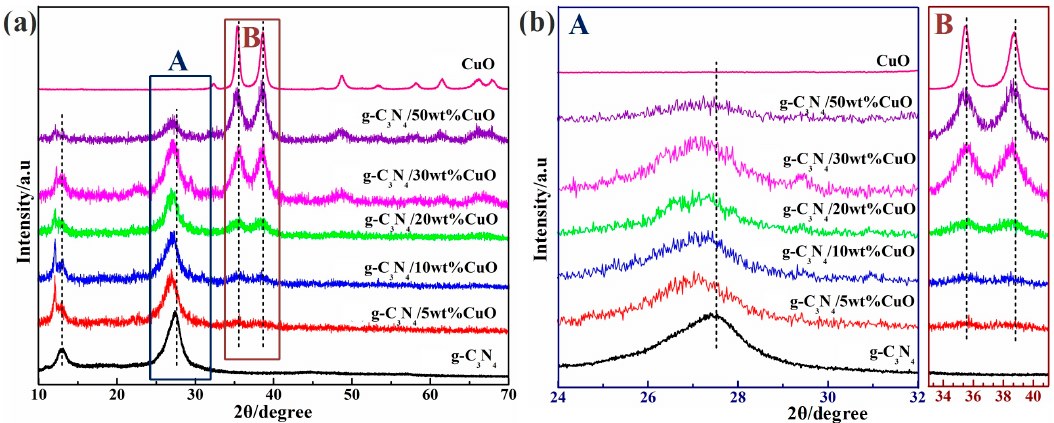
Figure 1. ( a ) X-ray diffraction (XRD) patterns of pure g-C 3 N 4 , CuO and g-C 3 N 4 /CuO